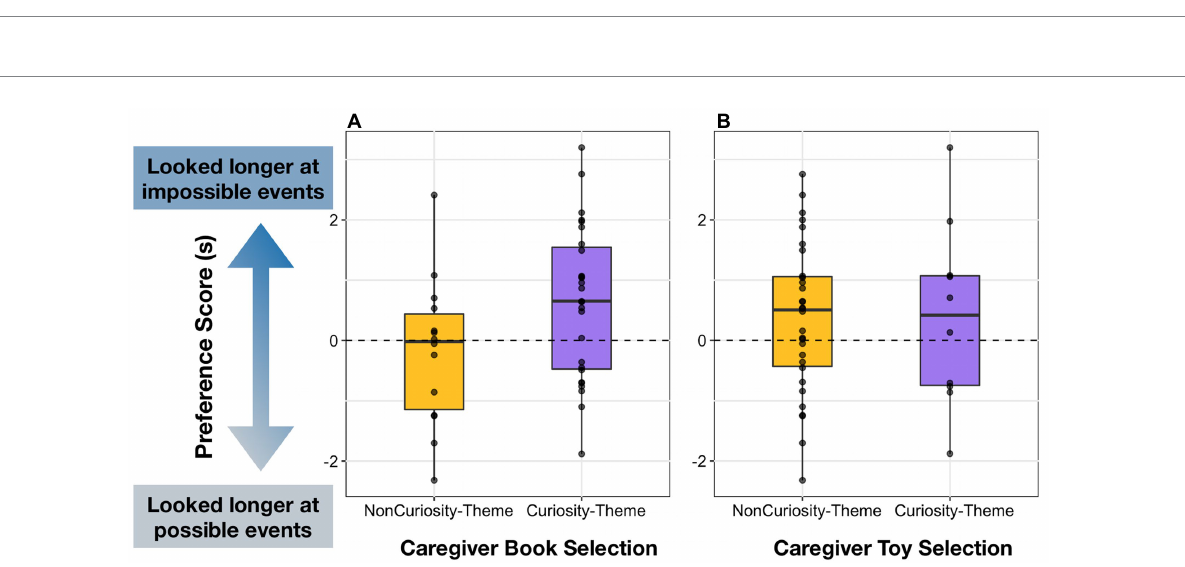
FIGURE 4 Infants’ Preference Score based on caregivers’ curiosity-themed book and toy selection for their child. In the Book Selection, parents were given three options: curiosity, prosociality, or counting. Prosociality and counting books were coded as a non-curiosity-themed book. In the Toy Selection, participants were given three options: curiosity, animal, or music. Animal and music toys were coded as a non-curiosity-themed book.